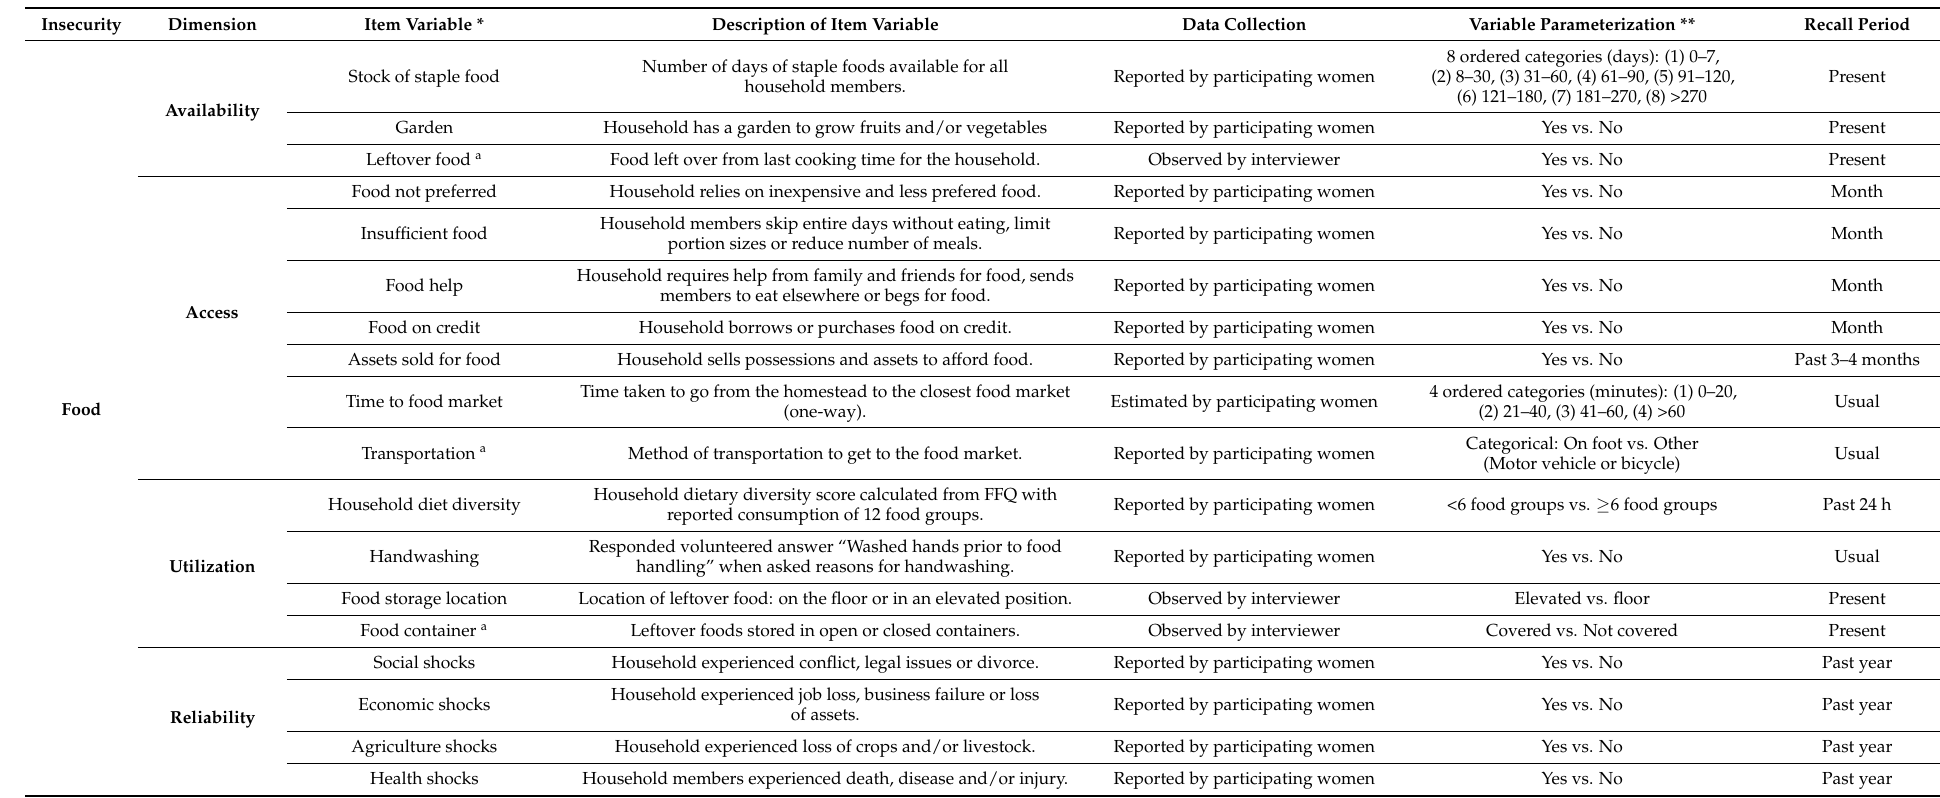
Table 1. Complete set of item variables from the Sanitation Hygiene and Infant Nutrition Efficacy (SHINE) trial considered for each dimension of household food insecurity and water insecurity, collected at baseline from November 2012 to March